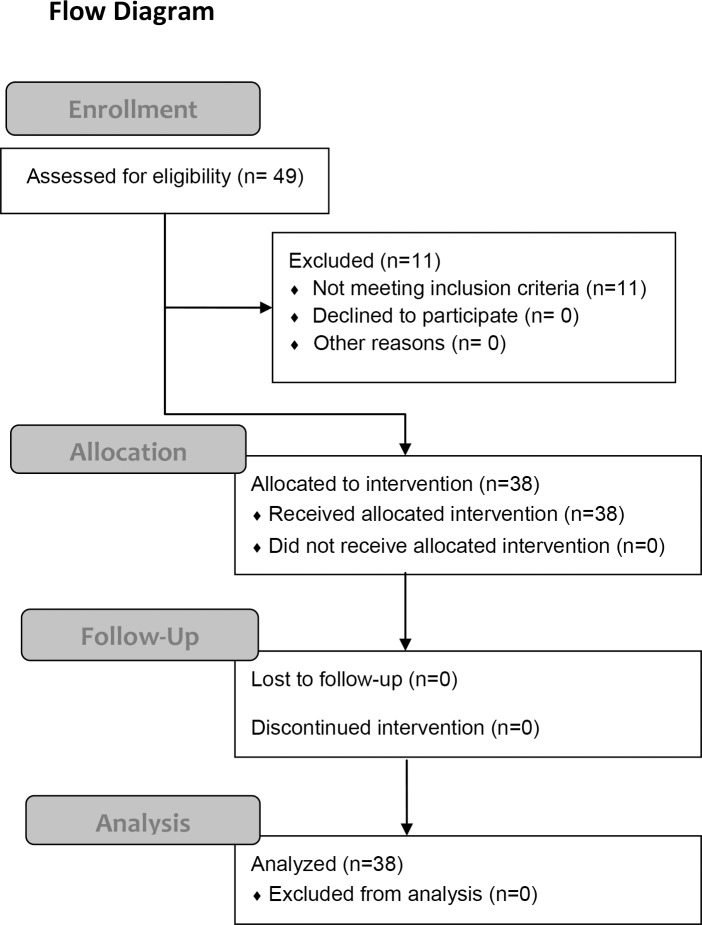
Flow diagram of all participants through the trial.